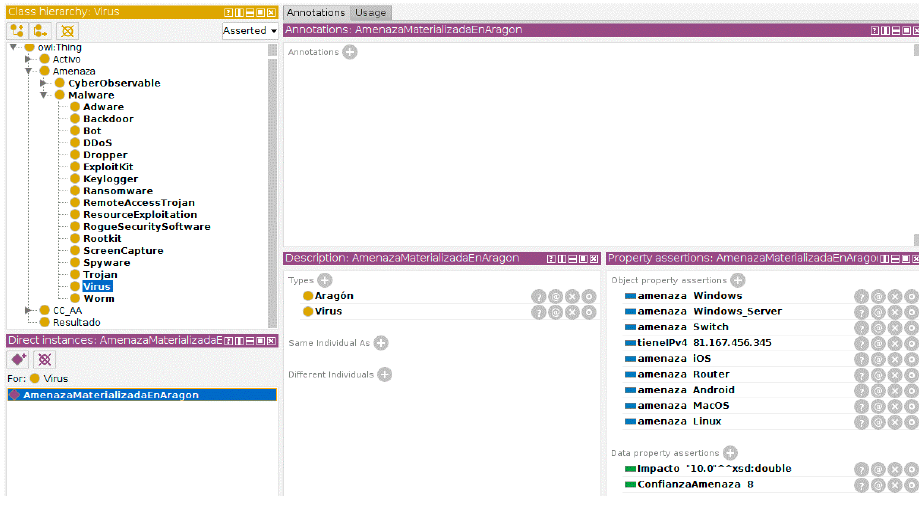
Figure 5. Information on a threat represented in an ontology.